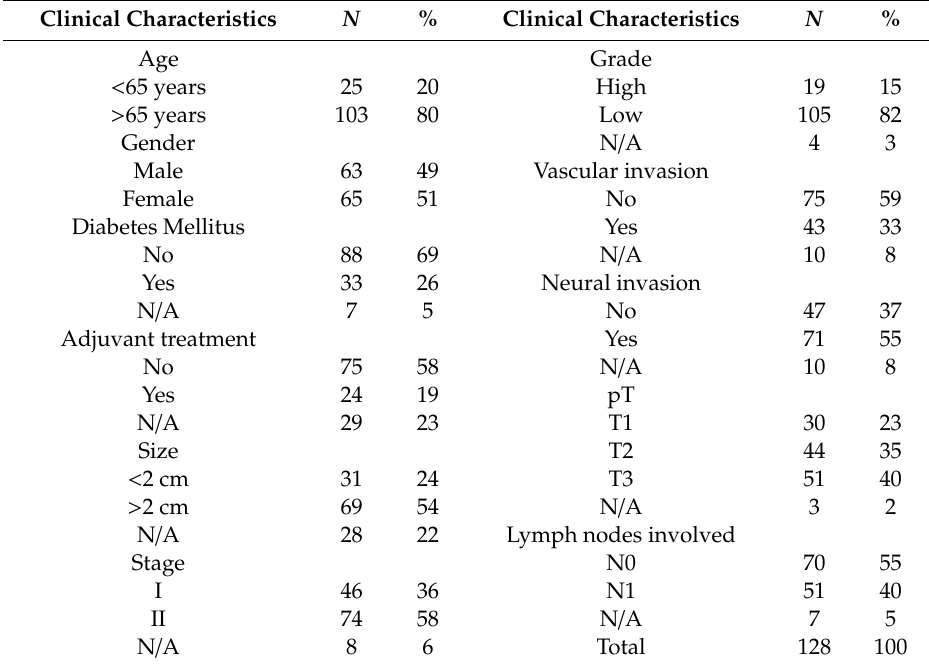
Table 2. Clinico-pathologic characteristics of complete resected R0 pancreatic cancer patients from the validation